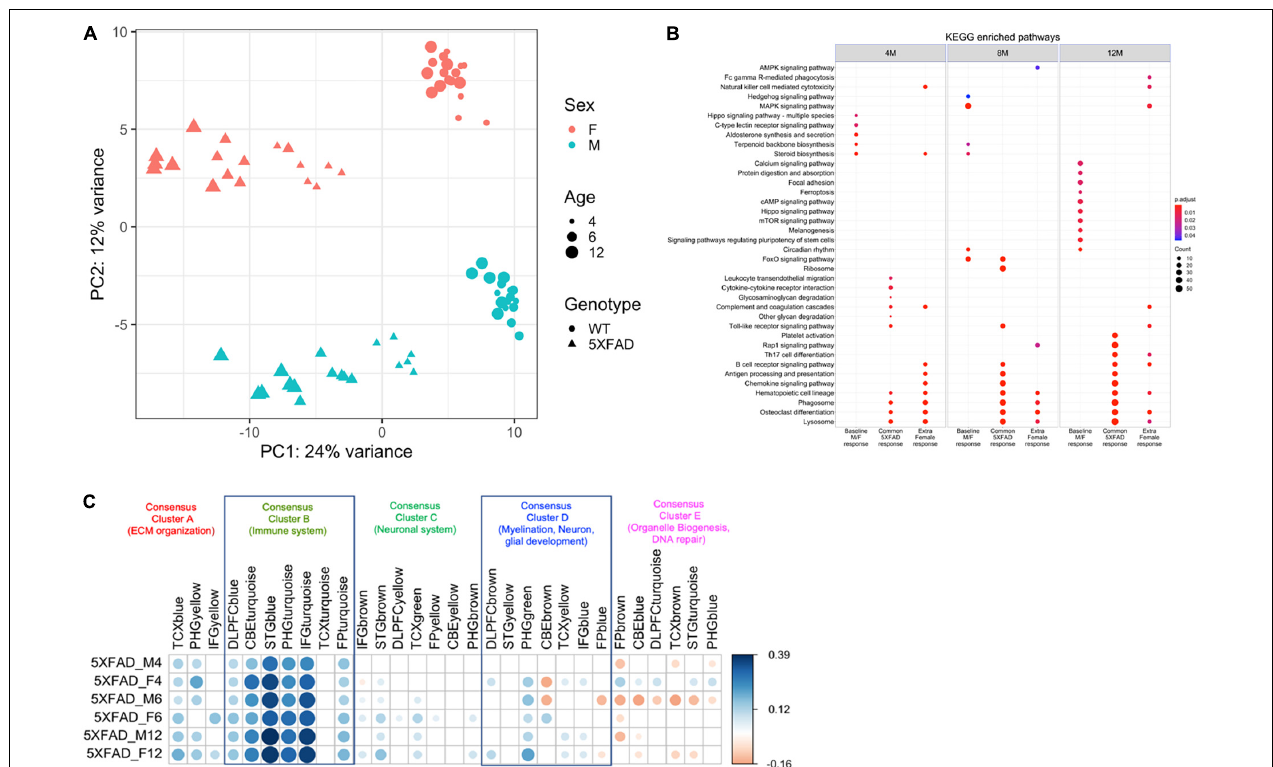
FIGURE 4 | Transcriptomics identified genotype and sex being a major source of variation in between 5XFAD and WT mice and a positive correlation with most of the functionally distinct AMP-AD modules. (A) The first principal component accounted for 23% of the total variance and separated 5XFAD samples from WT animals. Female and male samples clustered distinctly at all ages in the second principal component (11% of total variance), suggesting the presence of sex-biased molecular changes in animals. Female and male samples are shown in red and green colors, respectively. 5XFAD and WT controls are represented as circles and triangles, respectively. Increasing point sizes represent the increasing age of the mice (4, 6, and 12 months, respectively). (B) KEGG enrichment analysis for genes significantly associated with sex (female), genotype (5XFAD) and sex by genotype interaction (5XFAD female) relative to age-matched male B6 mice. (C) Pearson correlation coefficients for gene expression changes in mice (log fold change of the 5XFAD mice minus age-matched B6 mice) and human disease (log fold change for cases minus controls). AMP-AD modules are grouped into five previously identified consensus clusters describing the major functional groups of AD-related alterations. Positive correlations are shown in blue and negative correlations in red. Color intensity and size of the circles are proportional to the correlation coefficient. Correlations with adjusted p -value > 0.05 are considered non-significant and are left